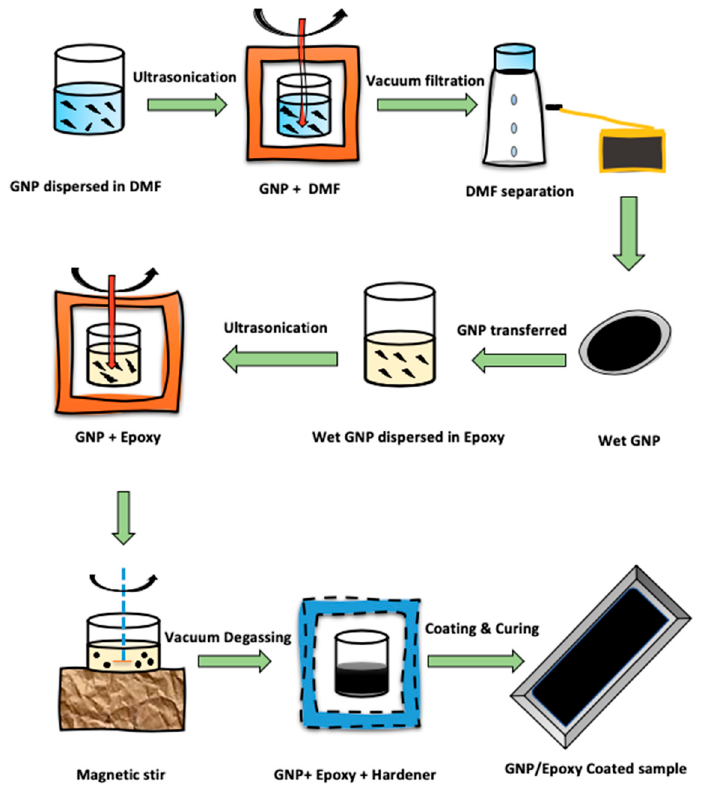
Figure 1. Schematic diagram of the preparation of graphene nanocomposites.